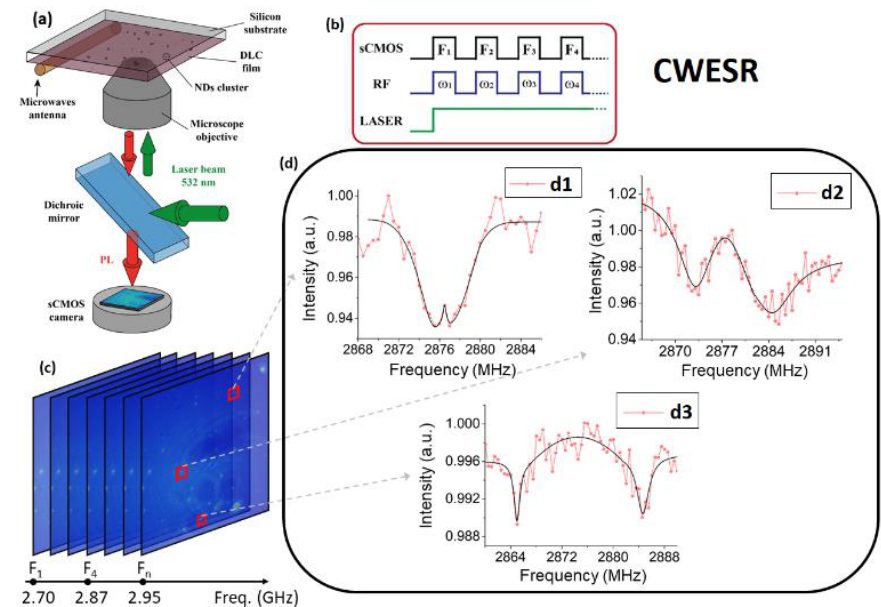
Figure 17. Spatially resolved OMDR wide-field imaging and strain-field dependence. Panel ( a ): Schematics of the inverted wide-field ODMR microscope. The green laser is steered onto the sample and focused through the 40 × objective through a dichroic mirror transmitting the red photoluminescence. The RF irradiation is obtained with an Au-coated copper loop, here represented by the microwave antenna wire located under the sample’s surface. Panel ( b ): Temporal diagram of the continuous wave electron spin resonance experiment. The camera detects the PL image synchronously with the RF irradiation, and the laser is kept ON all along the measurement time. Panel ( c ) Photoluminescence images as the RF frequency sweeps in the 2.85–2.90 GHz range. An ROI (red square) containing a bright spot was selected and the average intensity inside that ROI was plotted as a function of the RF frequency to generate an ODMR spectrum. Panel ( d ) reports three typical examples of signals on diamond nano-agglomerates showing di ff erent strain e ff ects (curves d1, d2, and d3). Reproduced with permission from [64], Royal Society of Chemistry, 2018.